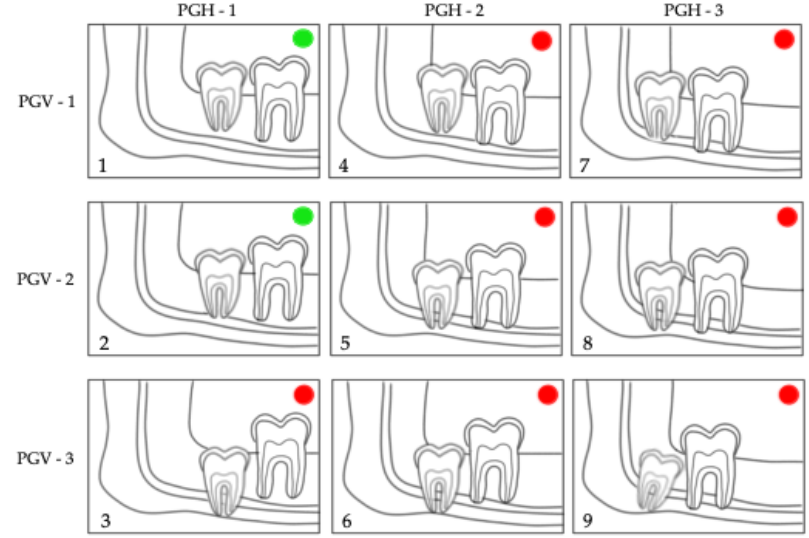
Figure 5. Pell & Gregory´s classification of mandibular M3 in relation to the horizontal (PGH) and vertical (PGV) position of M2 [25]. Reference plane/structure: the occlusal plane (PGV) and the ramus (PGH). Subdivisions according to the eruption prognosis of M3 in 1 , 2 : good ( ); 3 – 9 : bad prognosis ( ).